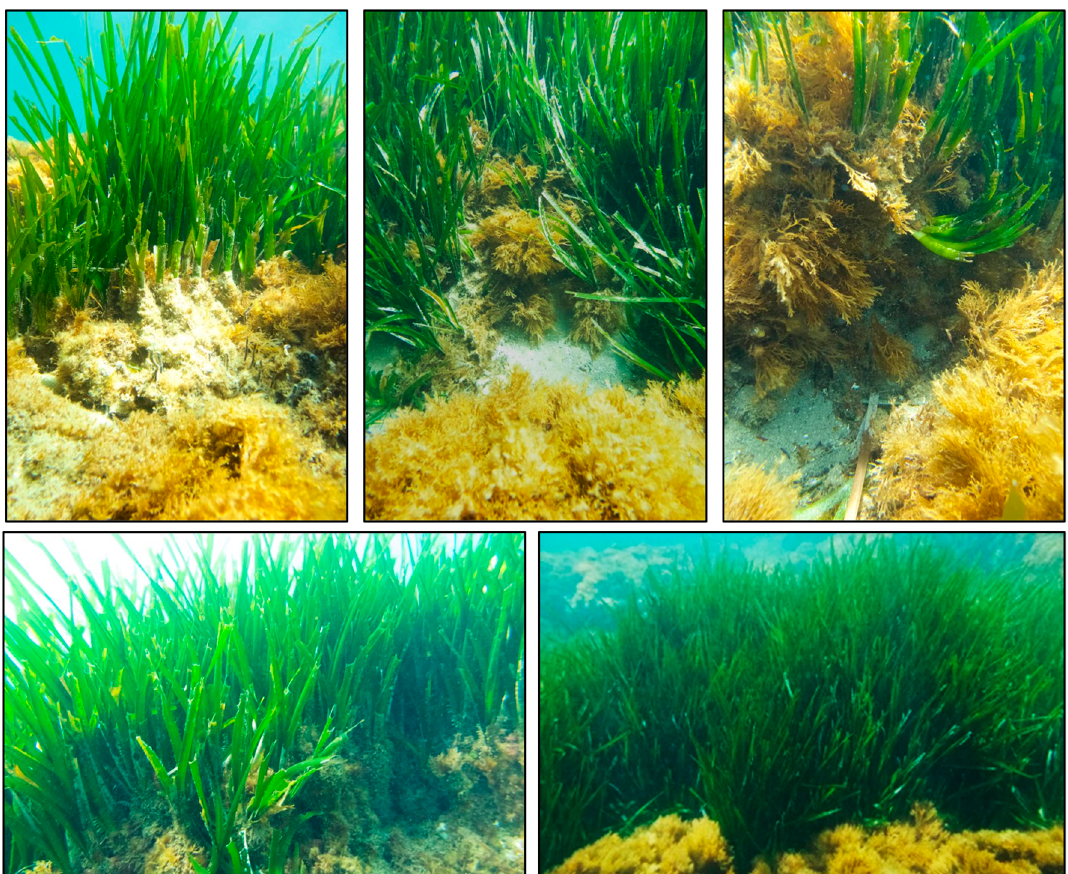
Figure 2. Photographs of the newly documented P. oceanica population surrounded by the invasive algae R. okamurae at Cala Sardina (36°18 ′ 38.80 ′′ N, 5°15 ′ 15.13 ′′ W).